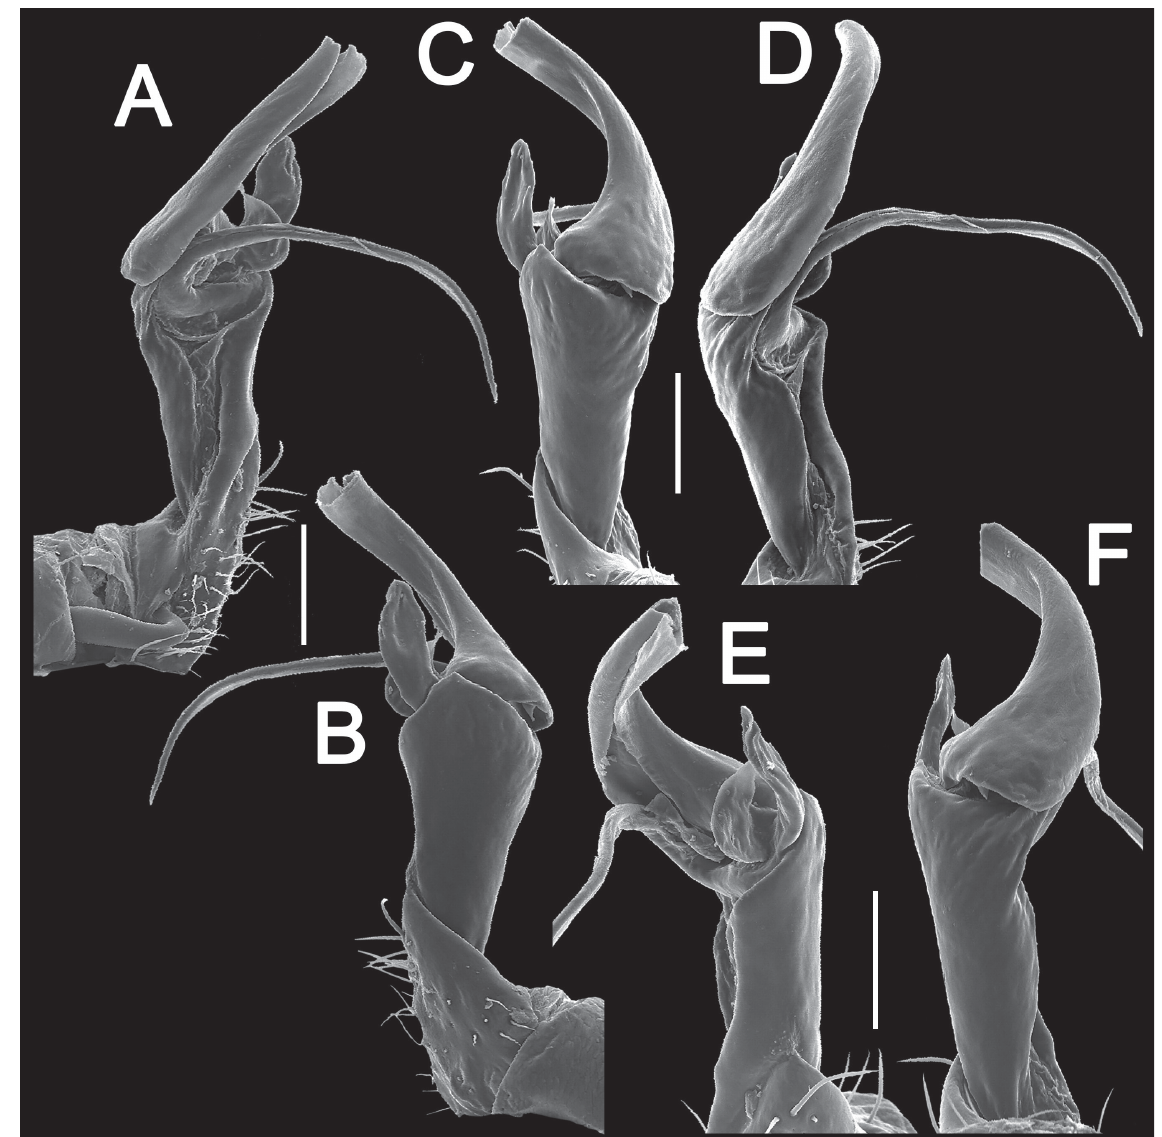
Fig. 6. Tylopus hongkhraiensis sp. nov., holotype, ♂, left gonopod. A–B . Mesal and lateral views, respectively. C–F . Distal part, sublateral, submesal, suboral and subcaudal views, respectively. Scale bars = 0.1